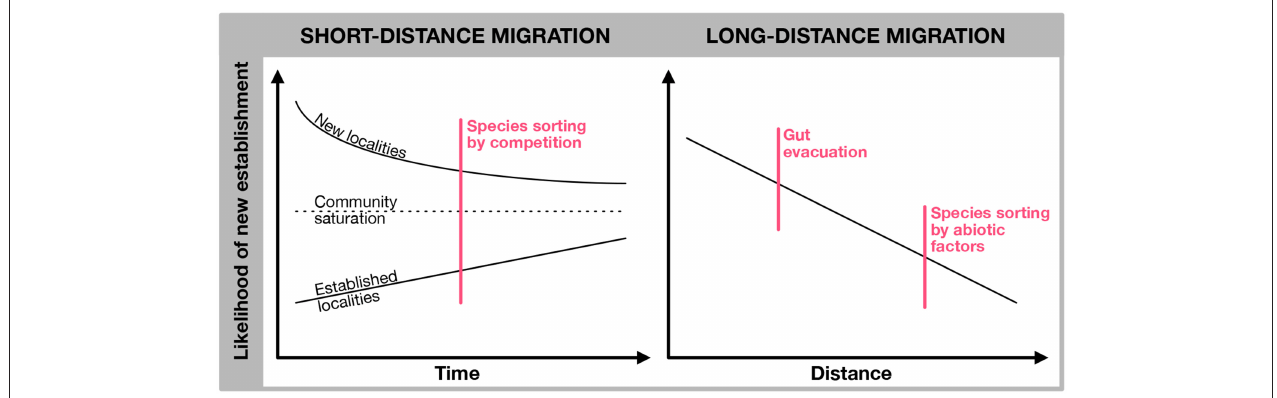
FIGURE 1 | Conceptual diagram for likelihood of dispersal, local sorting and establishment of zooplankton mediated by birds. Right panel displays the likelihood of local dispersal and establishment in recently formed and established (and species saturated) systems, respectively. In new localities with many available niches and low competition, initial likelihood of establishment is high, but will decrease over time as the system approach “saturation”. A high turnover of species may still occur, and community composition may change, but the species richness does not increase. As the systems becomes established, the chance of new establishment will be small, but still the cumulative likelihood of establishment will increase over time. The right panel illustrate how likelihood of establishment decrease with migration distance, partly owing to increased likelihood of complete gut evacuation prior to arrival at the recipient site, partly due to increased likelihood of different abiotic conditions in donor sites and recipient sites. The vertical red lines represent constraints that in principle operate gradually over time and